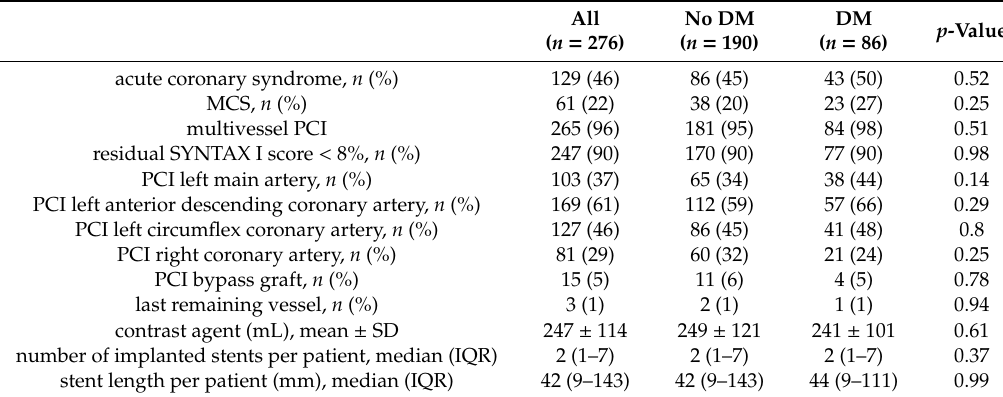
Table 2. Procedural